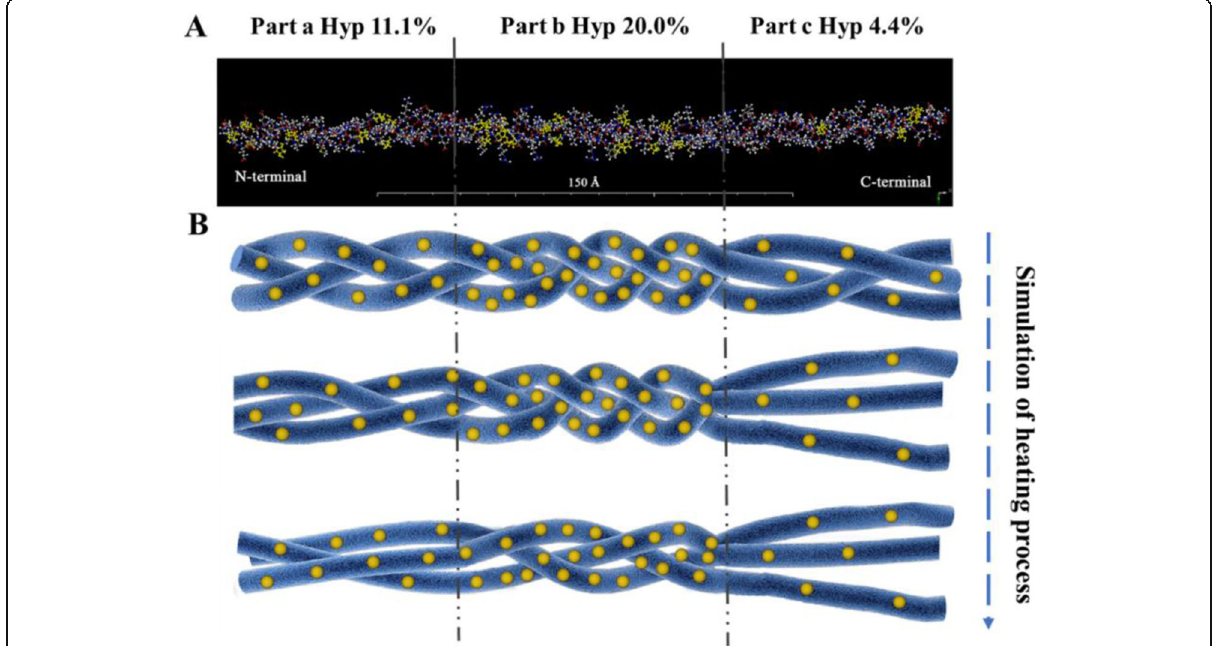
Fig. 4 ( a ) The optimal molecular model. The yellow-marked amino acid is Hyp. ( b ) The schematic diagram of structural changes of a collagen model during degeneration. The yellow dots represent the distribution of Hyp. Adapted with permission from [131]. Copyright © 2019, American Chemical